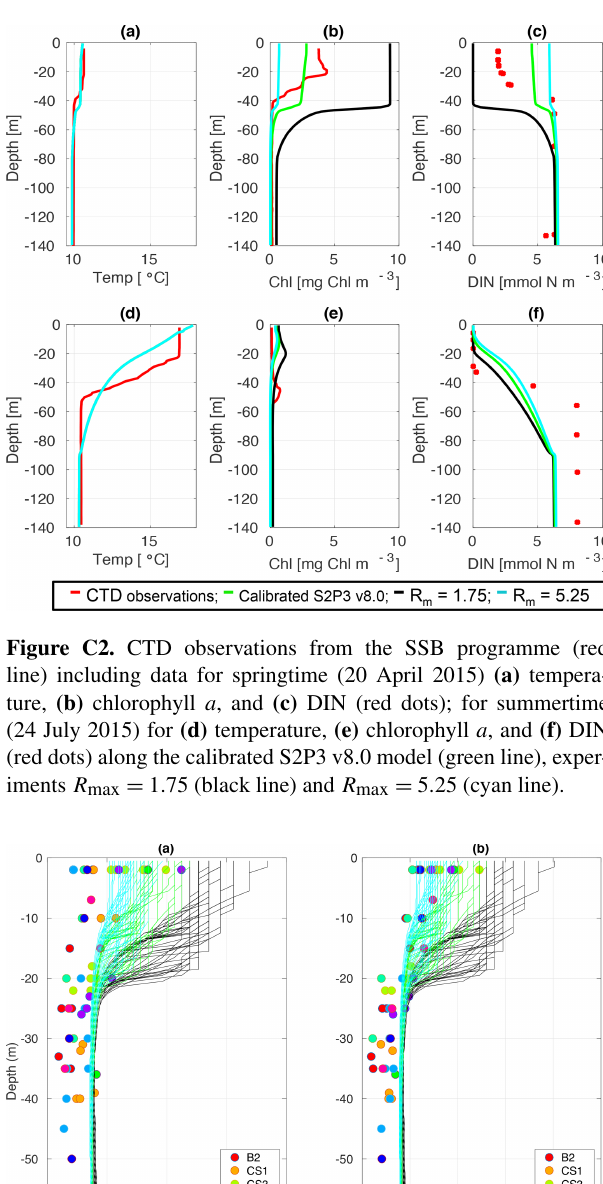
(cid:16) (cid:17) P Chl max and (b) light saturation